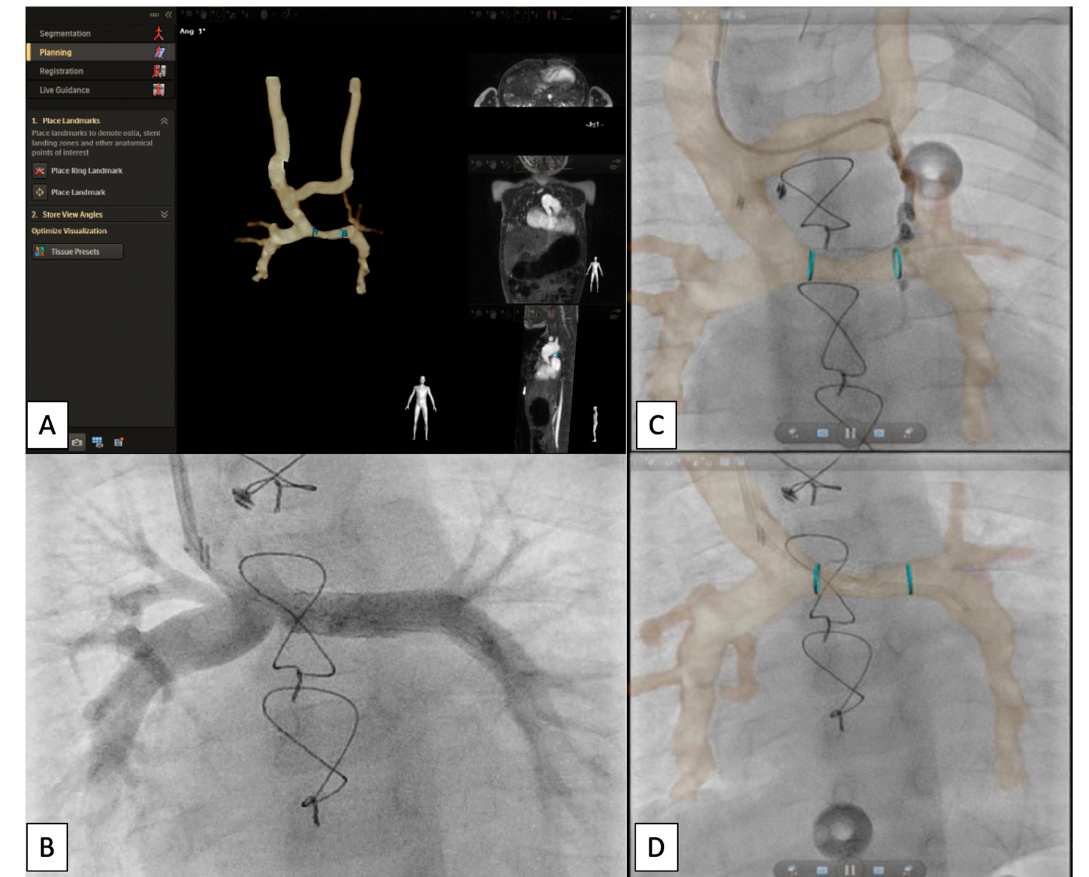
Figure 15. Series of images depicting overlay planning ( A ) and intervention on a small veno-venous collateral ( B ) as well as left pulmonary artery (LPA) stenting ( C , D ) in a CHD patient status post Glenn palliation. Revised from ref [9].